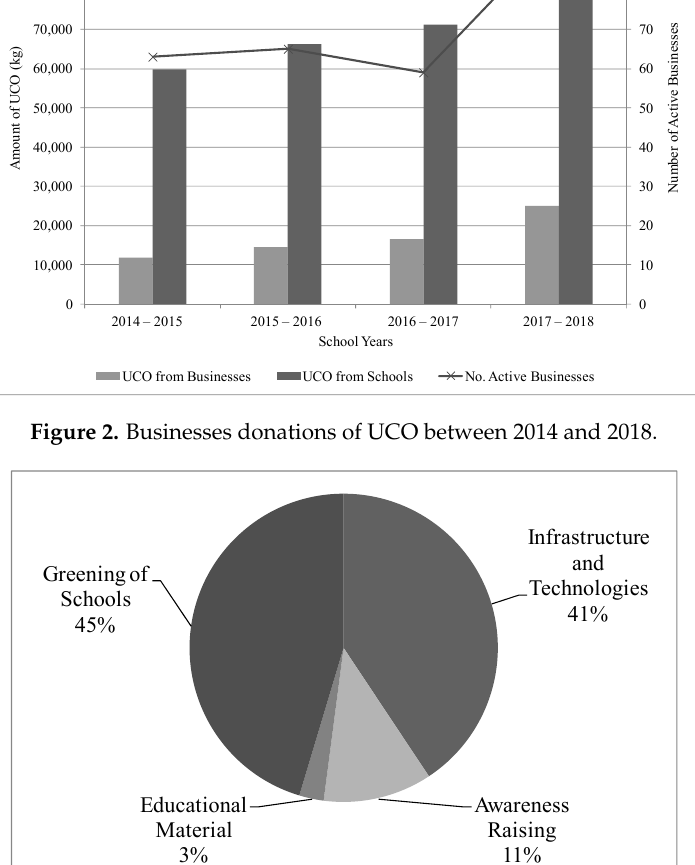
Figure 3. Modes of investment of InnovOleum funds by schools .